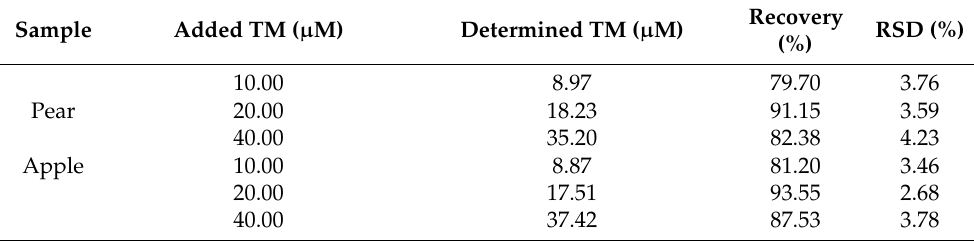
Figure 9. Schematic diagram of pesticide residue detection in pear and apple. Table 2. Determination of TM in real samples ( n = 3).